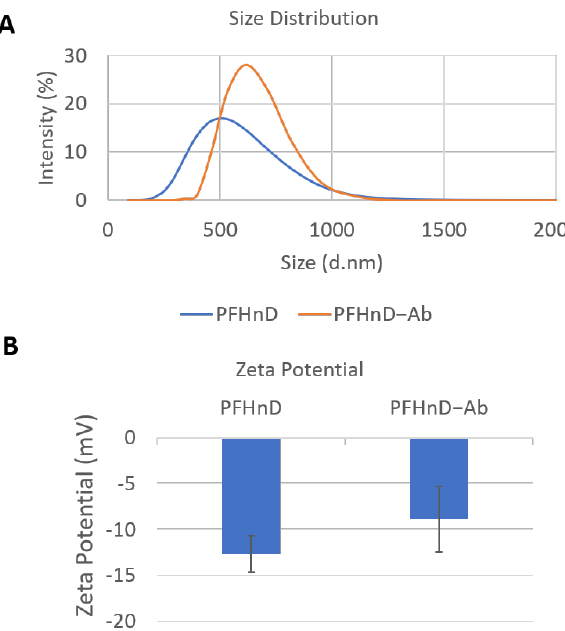
Figure 3. ( A ) The size distribution of both the non-targeted PFHnDs (534.2 ± 37.5 nm; n = 3) and antibody conjugated PFHnD-Ab (641 ± 48.5 nm; n = 3). ( B ) The zeta potential of both targeted (PFHnD-Ab; − 8.88 ± 3.54 mV; n = 3) and non-targeted (PFHnD; − 12.7 ± 2.01 mV; n = 3)